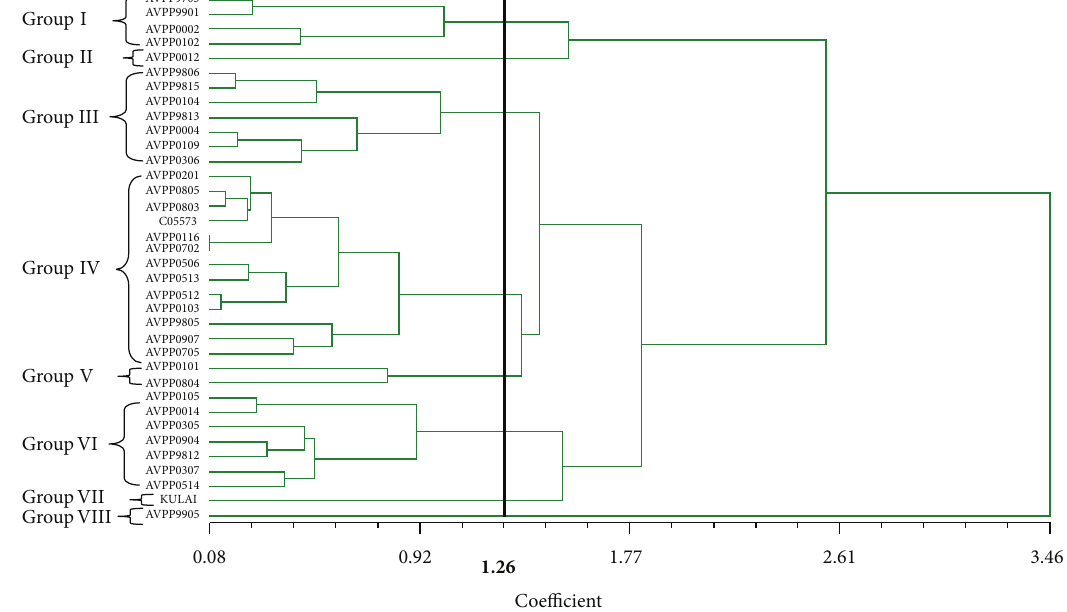
Figure 3: Relationship among the 36 chilli pepper genotypes based on cell membrane thermostability and yield characters using SAHN clustering on UPGMA